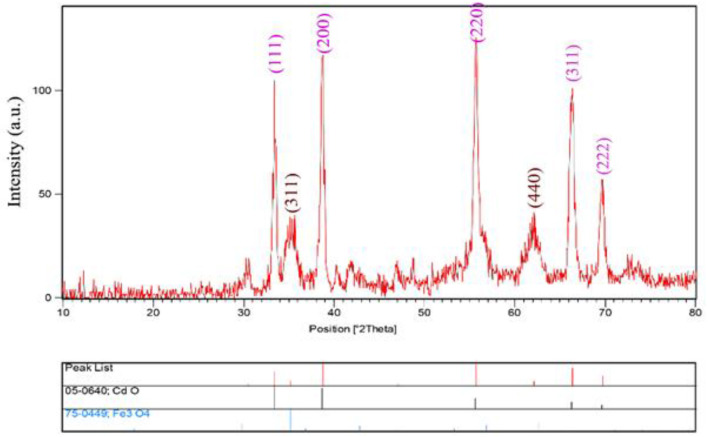
The XRD pattern of CdO/Fe3O4.